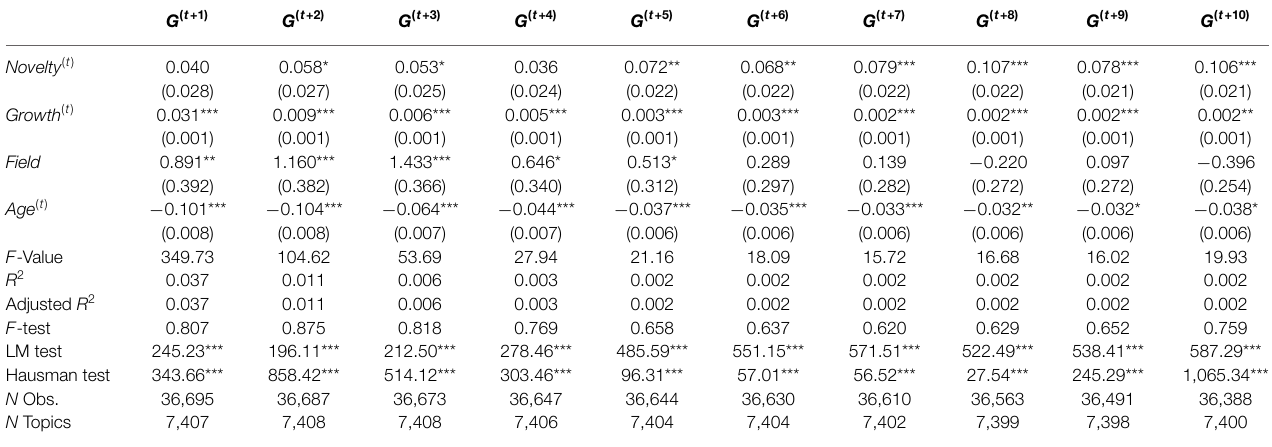
TABLE 6 | Growth ( t + ∆ t ) random-effect models